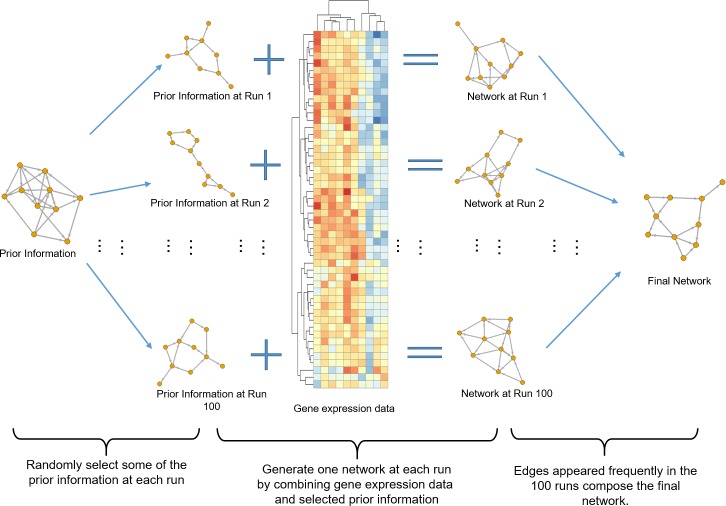
Algorithm workflow.